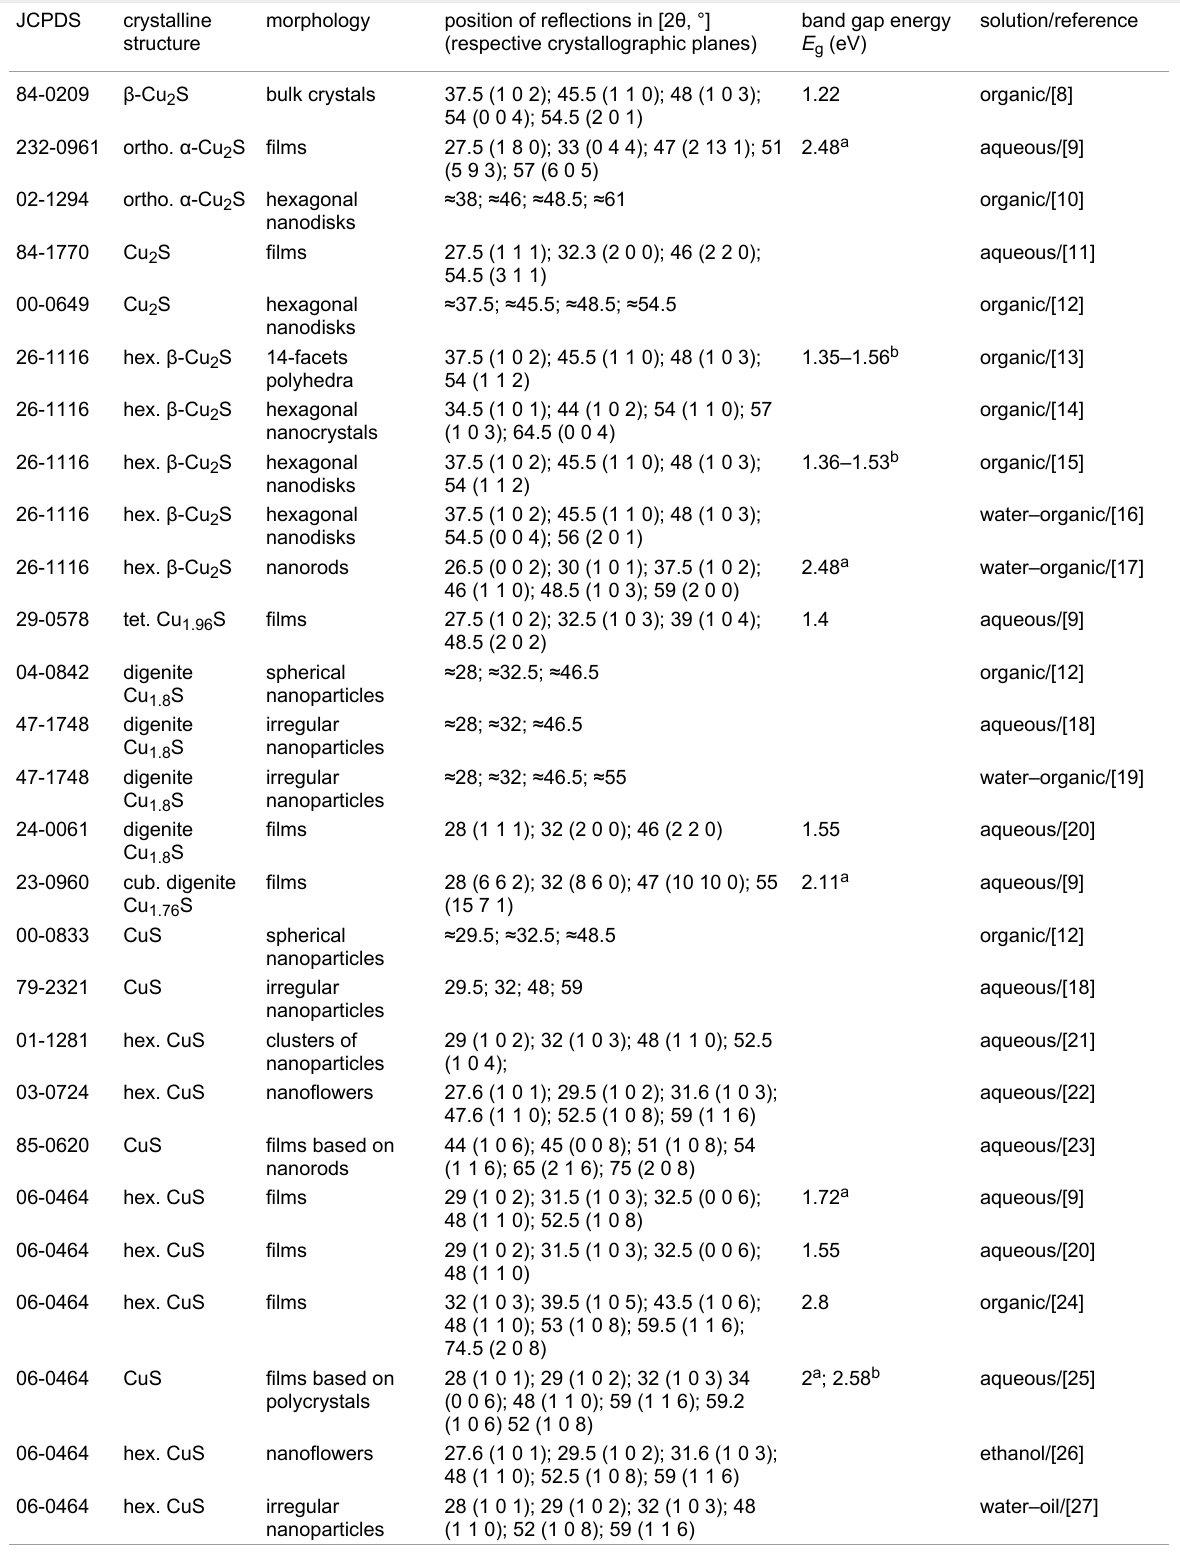
a Direct band gap; b indirect band